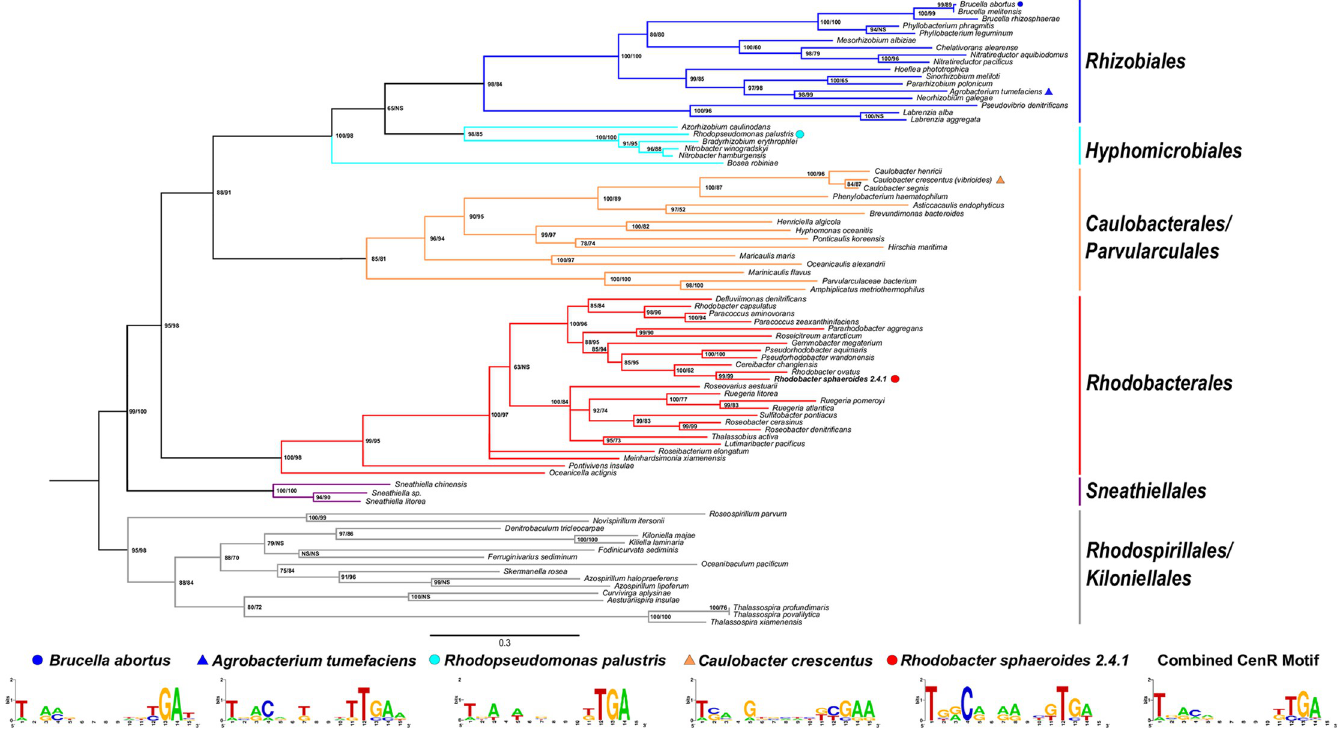
Fig 6. Homologs of CenKR are found in several other α -proteobacteria. (Phylogeny) Combined maximum likelihood phylogenetic tree of CenK and CenR identified in α -proteobacteria which had identical topologies. Support values (ML bootstrap) for CenK/CenR are listed for each node. Support values under 50 are labeled NS. (Bottom panel) Putative sequence logo of the CenR DNA binding motif derived from analyzing the regions upstream of transcriptional units directly controlled by CenR in indicated α -proteobacteria.